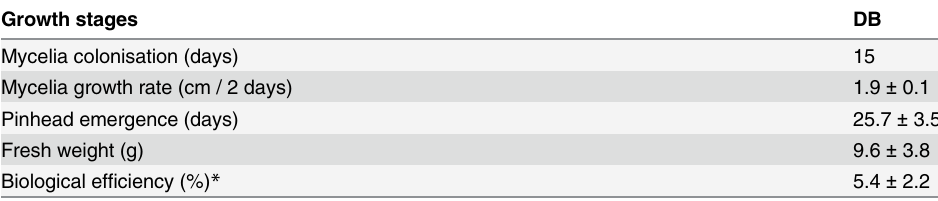
Table 2. The colonisation of sawdust bags and basidiocarp formation by A . rugosum . Growth